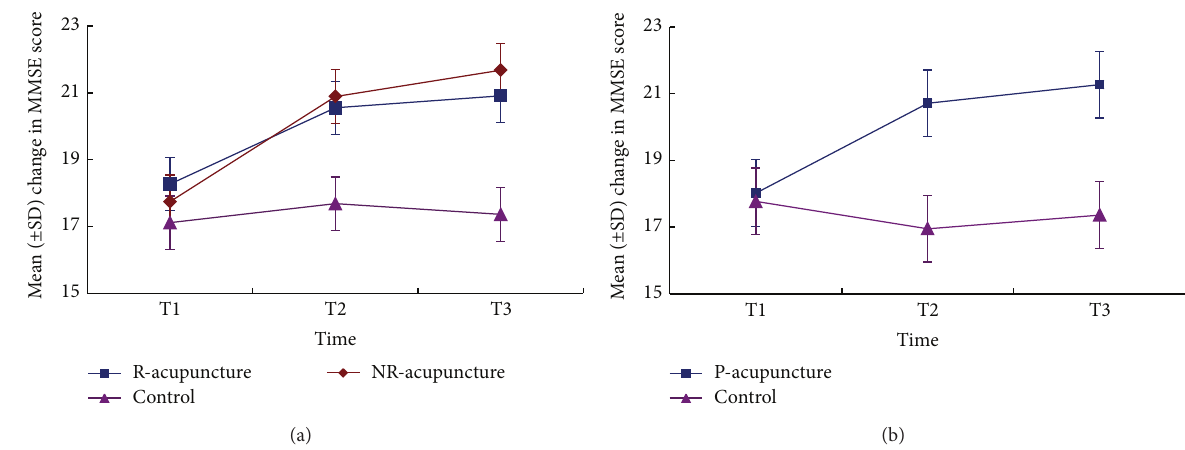
Figure 2: The changes of score in MMSE across time. Comparison among R-acupuncture group, NR-acupuncture group, and control group (a) and between pooled-acupuncture group and the control group (b). R-acupuncture = randomized acupuncture group, Control = control group, NR-acupuncture = nonrandomized acupuncture group, and P-acupuncture = pooled-acupuncture group. T1 = at baseline, T2 = after 6-week treatment, and T3 = after 4-week follow-up.